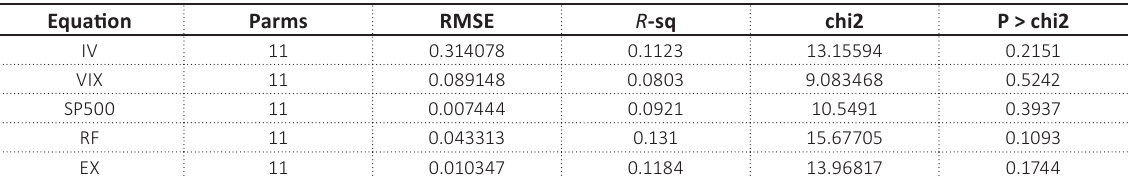
Table A2. Vector autoregressive model